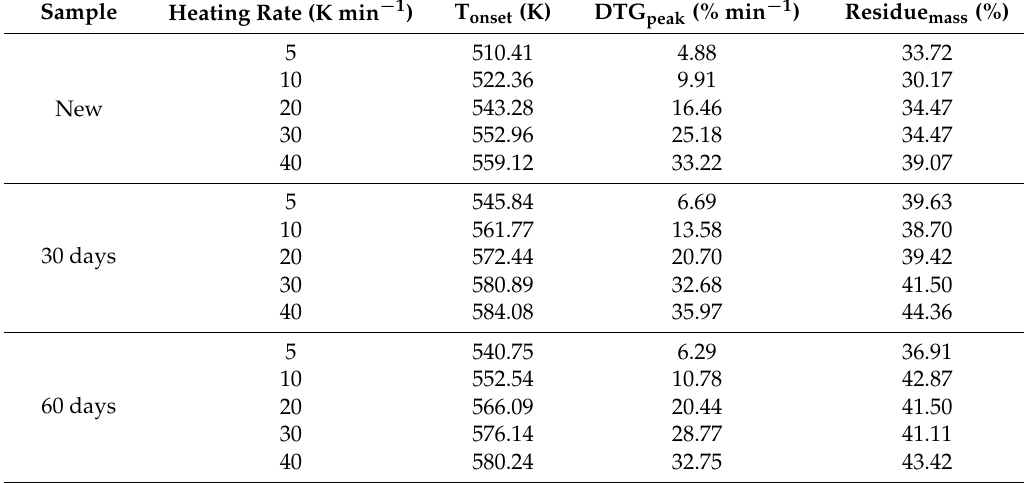
Table 2. Pyrolysis parameters of PVC sheaths for new and aged cables in nitrogen atmosphere with different heating rates.